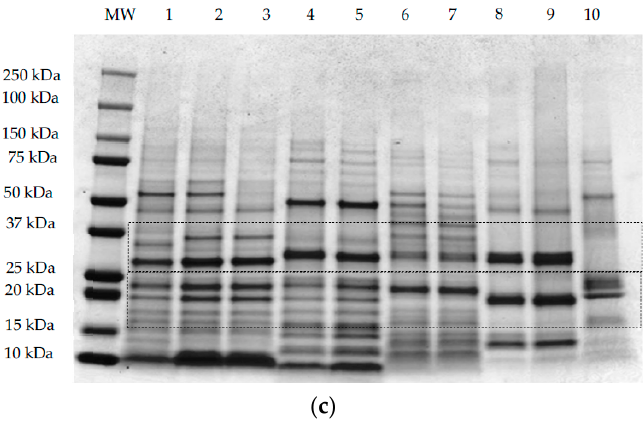
Figure 3. Representative sodium dodecyl sulphate–polyacrylamide gel electrophoresis (SDS-PAGE) patterns of quinoa wholegrain flour (1), quinoa dehulled flour (2), quinoa protein-rich flour (3), buckwheat dehulled flour (4), buckwheat protein-rich flour (5), amaranth wholegrain flour (6), amaranth protein-rich flour (7), rice flour (8), rice protein concentrate (9), and maize flour (10). The